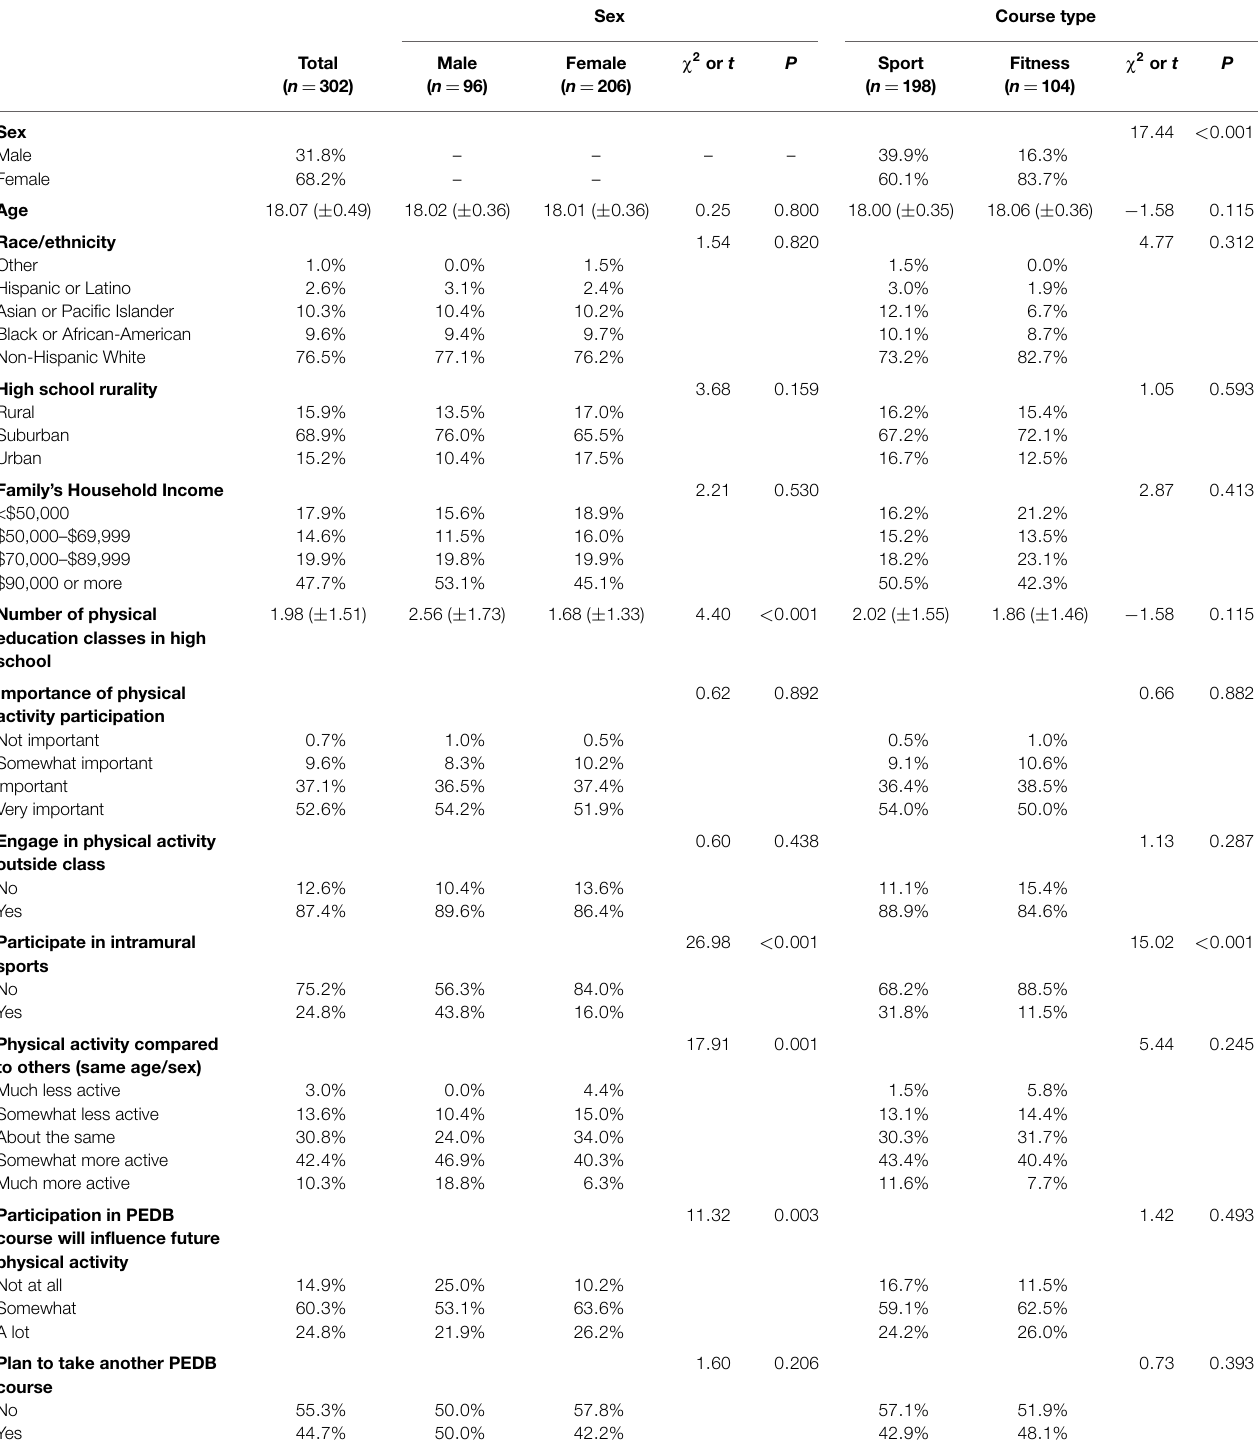
TABLE 1 | Sample characteristics and physical activity engagement among college students enrolled in asic physical education and activity courses . Sex Course